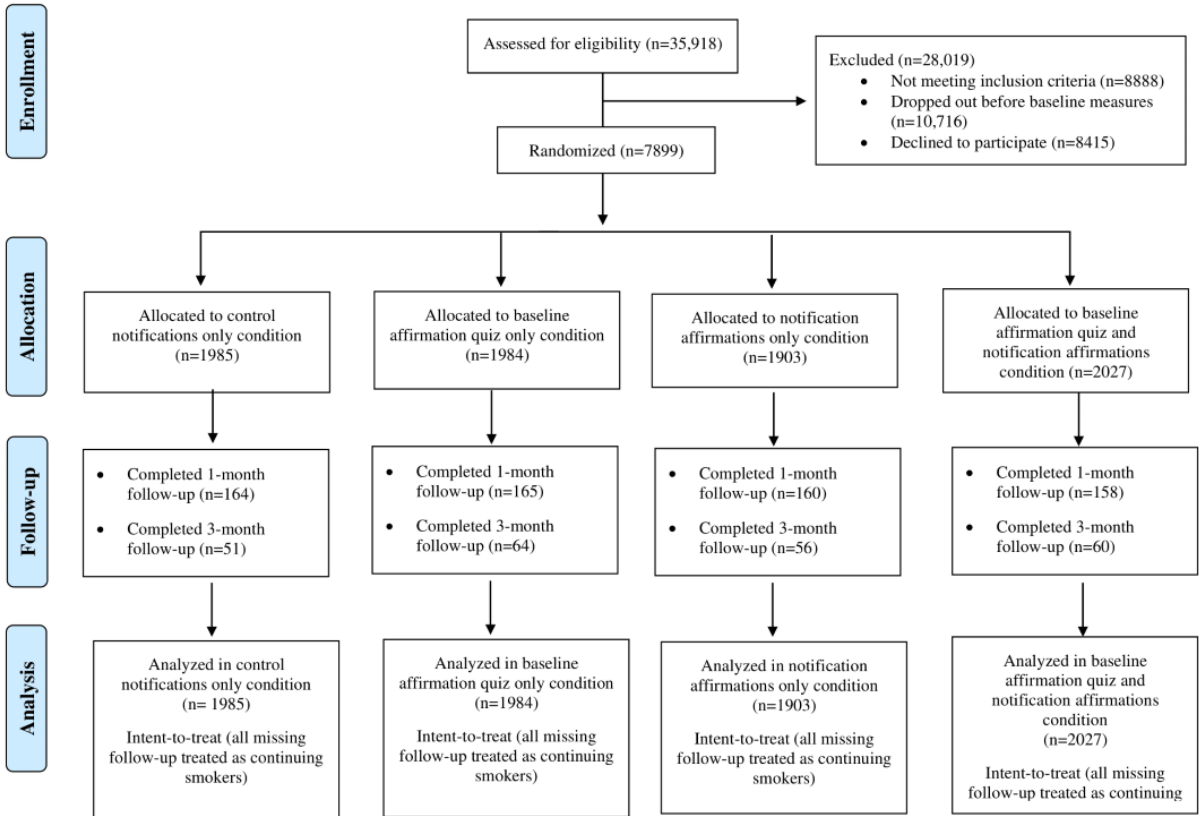
Figure 1. Consolidated Standards of Reporting Trials (CONSORT)